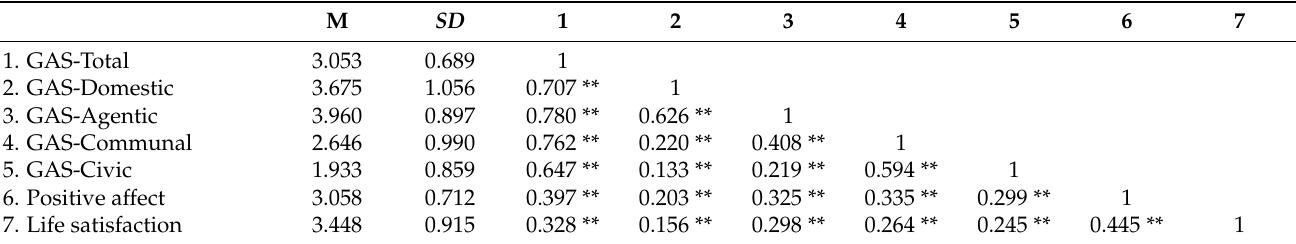
Table 6. Concurrent validity: Bivariate Pearson